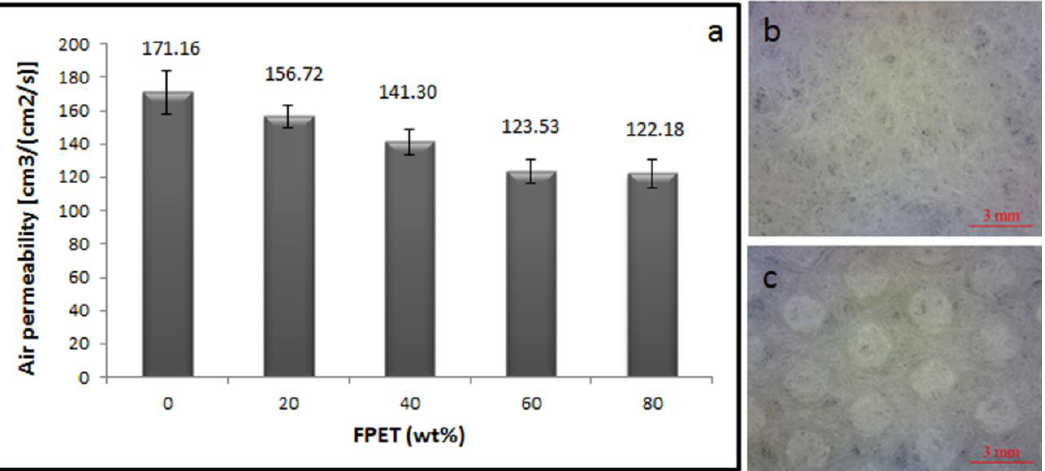
Figure 1. ( a ) Air permeability of nonwoven fabrics in relation to far-infrared polyester (FPET) content; ( b ) Stereomicroscopic images (6.7×) of the non-thermally treated and ( c ) thermally treated nonwoven fabrics.